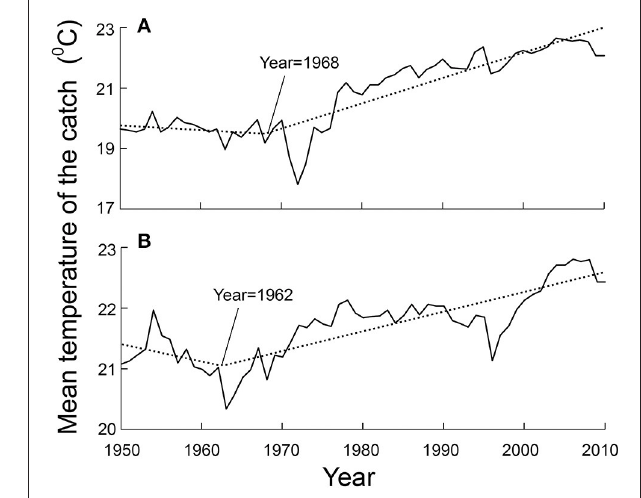
FIGURE 3 | Time series of MTC in three LMEs (A) and relationships (in B,C ) between the trends of MTC in the Yellow and East China Seas and the SSTs, with a lag of 3 years (see text and Table 1 ).